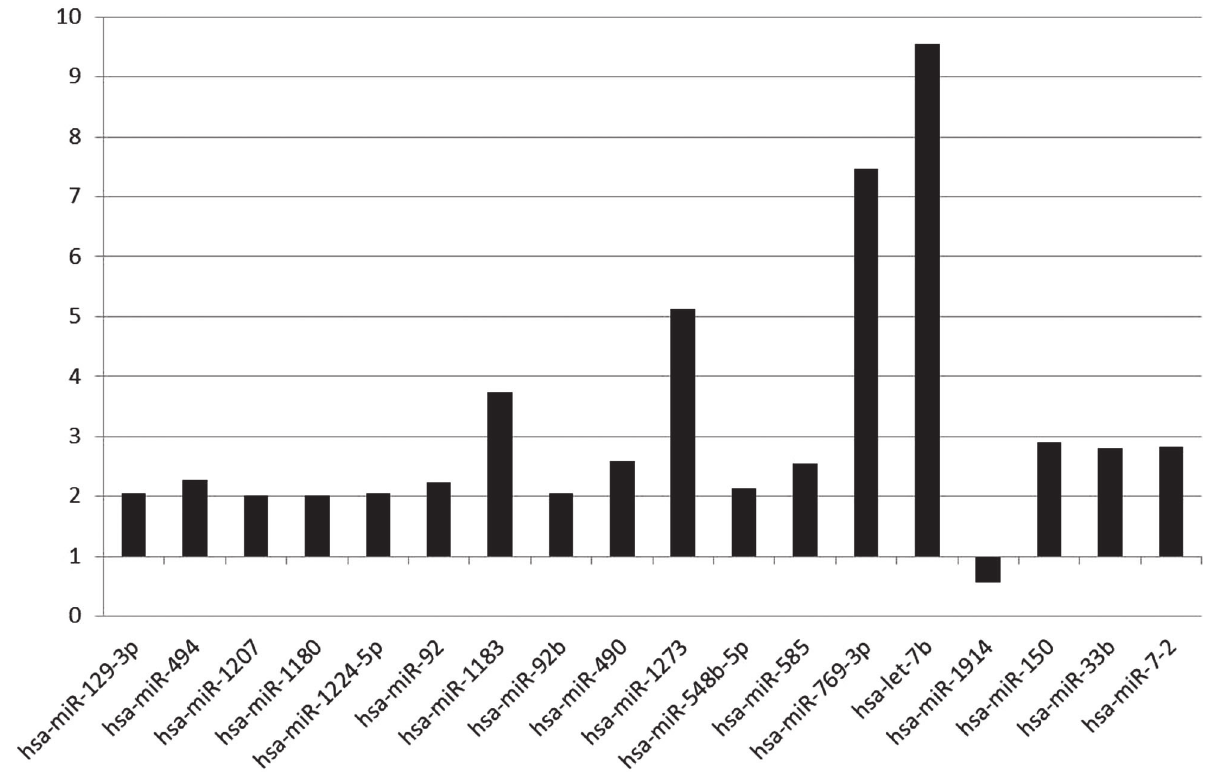
Figure 2. Fold change in plasma miRNA expression between three groups. miRNAs shown had expression increased >2-fold or decreased <0.5-fold for the groups; 1) patients with CAD; at least one of the coronary arteries have ≥ 70% occlusion; 2) patients with atherosclerosis but not clinically significant CAD; coronary occlusion 1%–<70%; and 3) coronary atherosclerosis-free, patients with no angiographically documented coronary artery